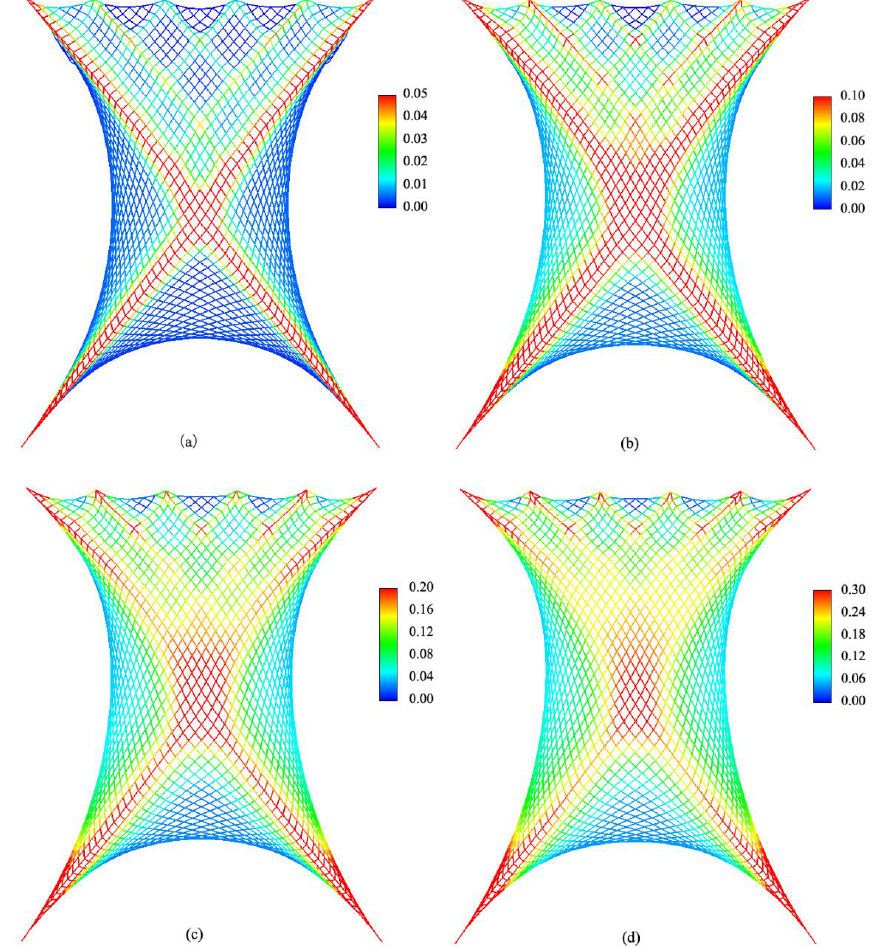
Figure 9. Three-dimensional graphic of the distribution of tension force on nets in current (unit: N): (a) U=0.05 m/s; (b) U=0.10 m/s; (c) U=0.15 m/s; and (d) U=0.20 m/s.